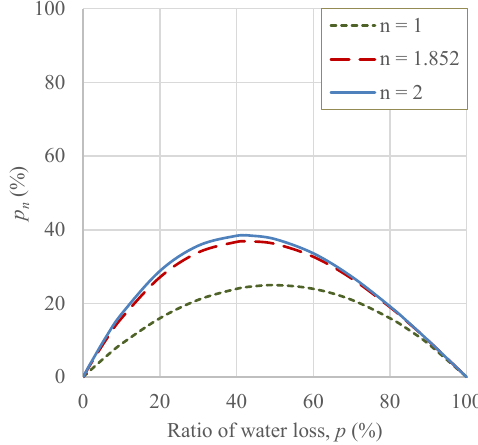
Figure 3. Relationship between parameter p n and ratio of water loss, p .